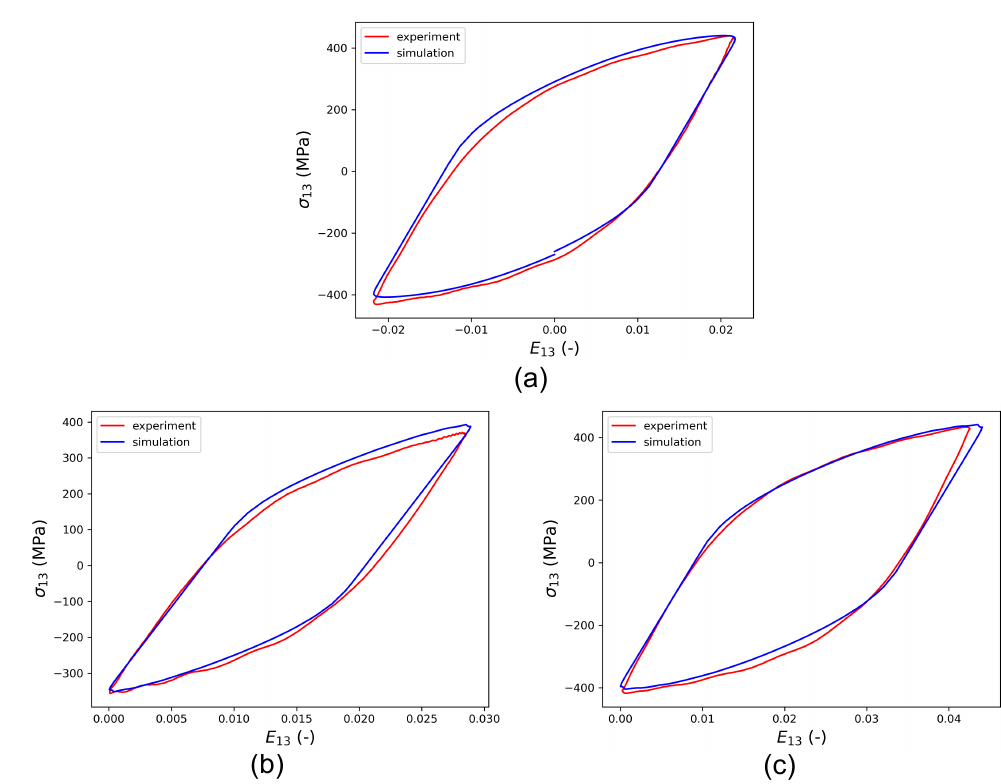
Figure 10. Comparison of saturated HPTF stress–strain hysteresis loops between simulation and experiment; the constant axial pressure amounts to σ 33 = 250 MPa in all cases and cyclic shear loading E 13 is applied to mimic the cyclic torsion in the experiment. ( a ) The result of calibration for HPTF loading with R = − 1, θ = 7.5 ◦ , E 13 = 0.02. The two subfigures in the bottom represent predictions of the model for ( b ) R = 0, θ = 10 ◦ , E 13 = 0.028, and ( c ) R = 0, θ = 15 ◦ , E 13 = 0.04.